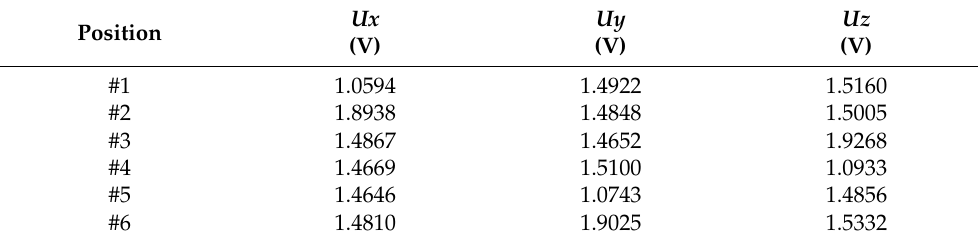
Table 3. Averaged values of the output voltages two hours after the